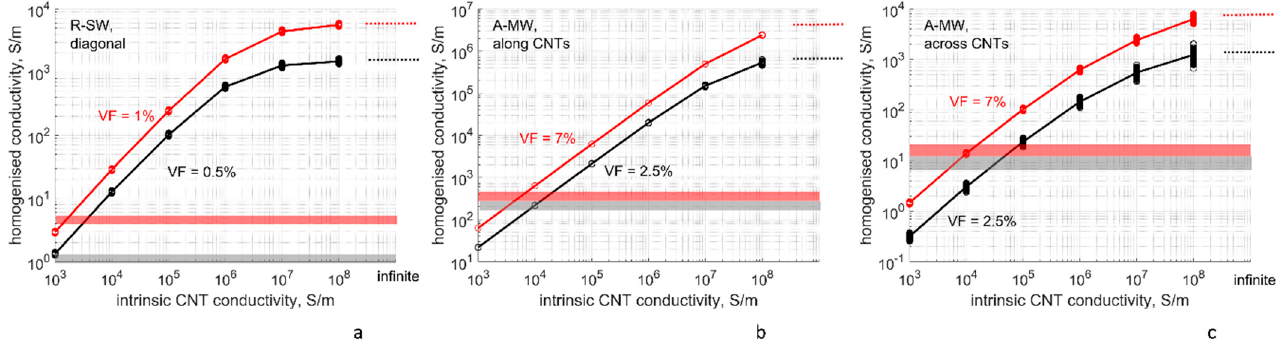
Figure 7. The homogenized conductivity as a function of the assumed intrinsic conductivity of CNTs, at two levels of the CNT volume fraction: ( a ) R-SW, diagonal components of the conductivity tensor; ( b ) A-MW, along CNTs; ( c ) A-MW, across CNTs. The dashed lines show homogenized conductivity calculated assuming infinite conductivity of CNTs. The points show conductivity values, corresponding to different RVE random realizations (sampling size ≥ 99 for all cases). Δ E 1 = 3 eV, s min = 0.34 nm, the lines show mean values. The horizontal boxes show the homogenized conductivity range measured for R-SW [65] and A-MW [69] experimentally. The colors of the lines, points, and boxes correspond to CNT volume fractions, as shown on the graphs.